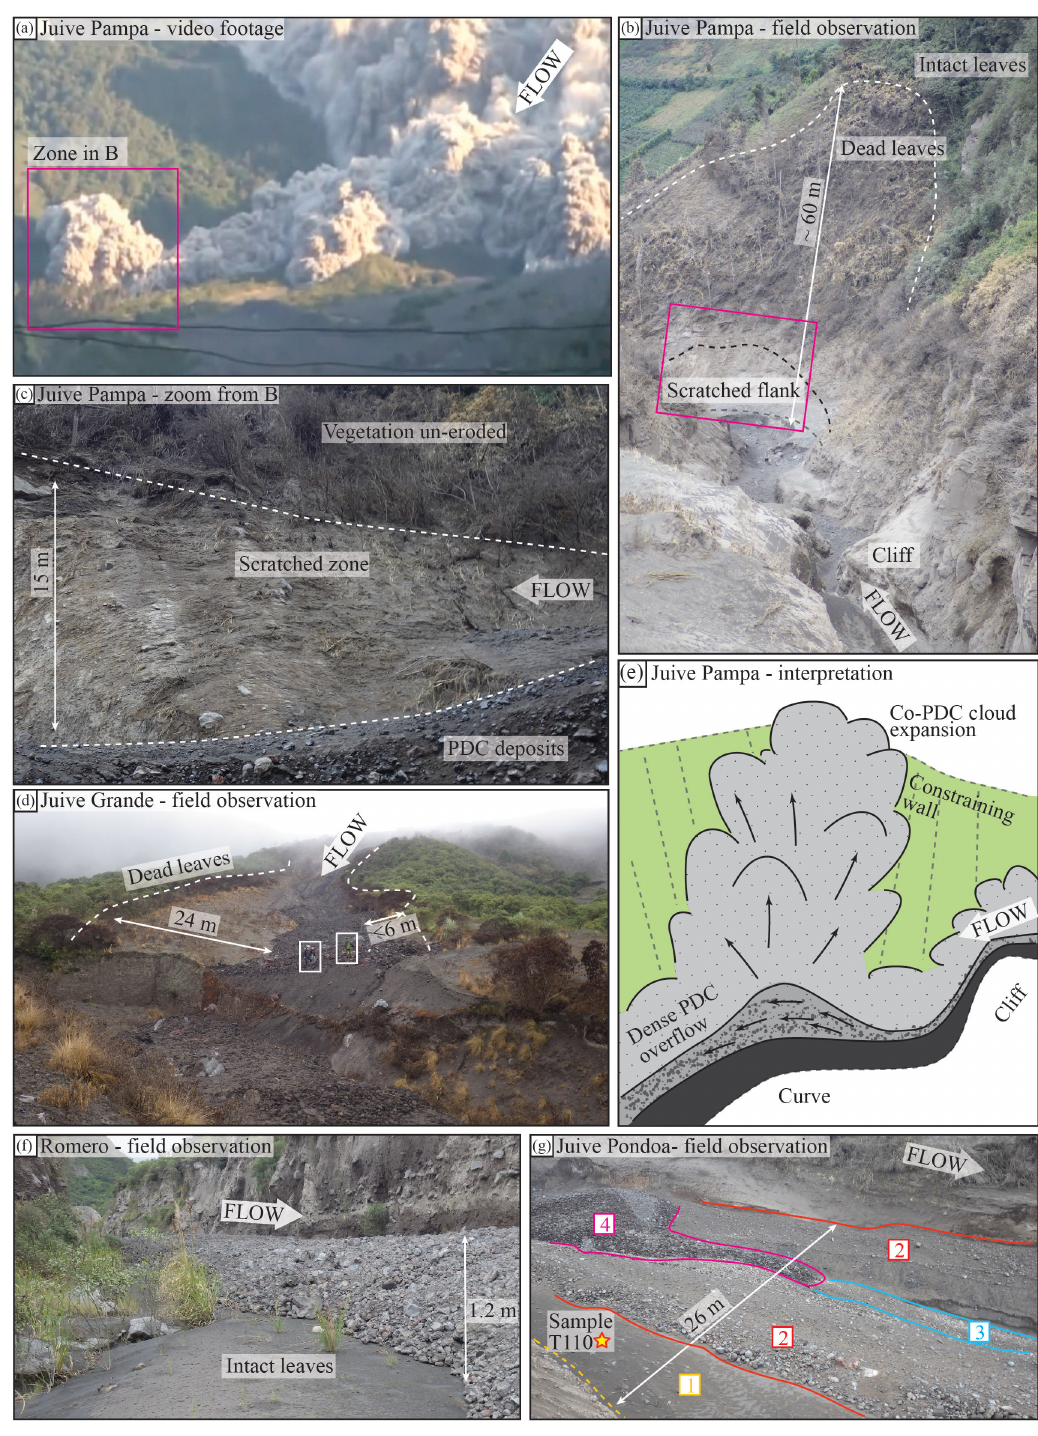
Figure 6. (a) Direct observation of PDCs during flow, YouTube video (C. F. Diego, https://www.youtube.com/watch?v=1pPr6wlFoDs). (b) Observation of PDCs’ impacts in zone highlighted in panel (a) , emphasising dead leaves due to co-PDC clouds in a topographically highly constrained valley, downstream of a cliff and on the outer overbank of a valley curve. (c) Zoom from B on the basal zone; note scratches. (d) The outer overbank of a valley curve shows no trees to the side of dense PDC deposits and damaged vegetation up to a distance of 24m, whereas damaged vegetation is visible only 6m to the side of the inner curve. (e) Interpretative sketch for panels (a) , (b) , and (d) . (f) In contrast, leaves are still standing less than 1m from PDCs in the lower Romero Valley. (g) At least four successive units are recognised in the Juive drainage–Pondoa